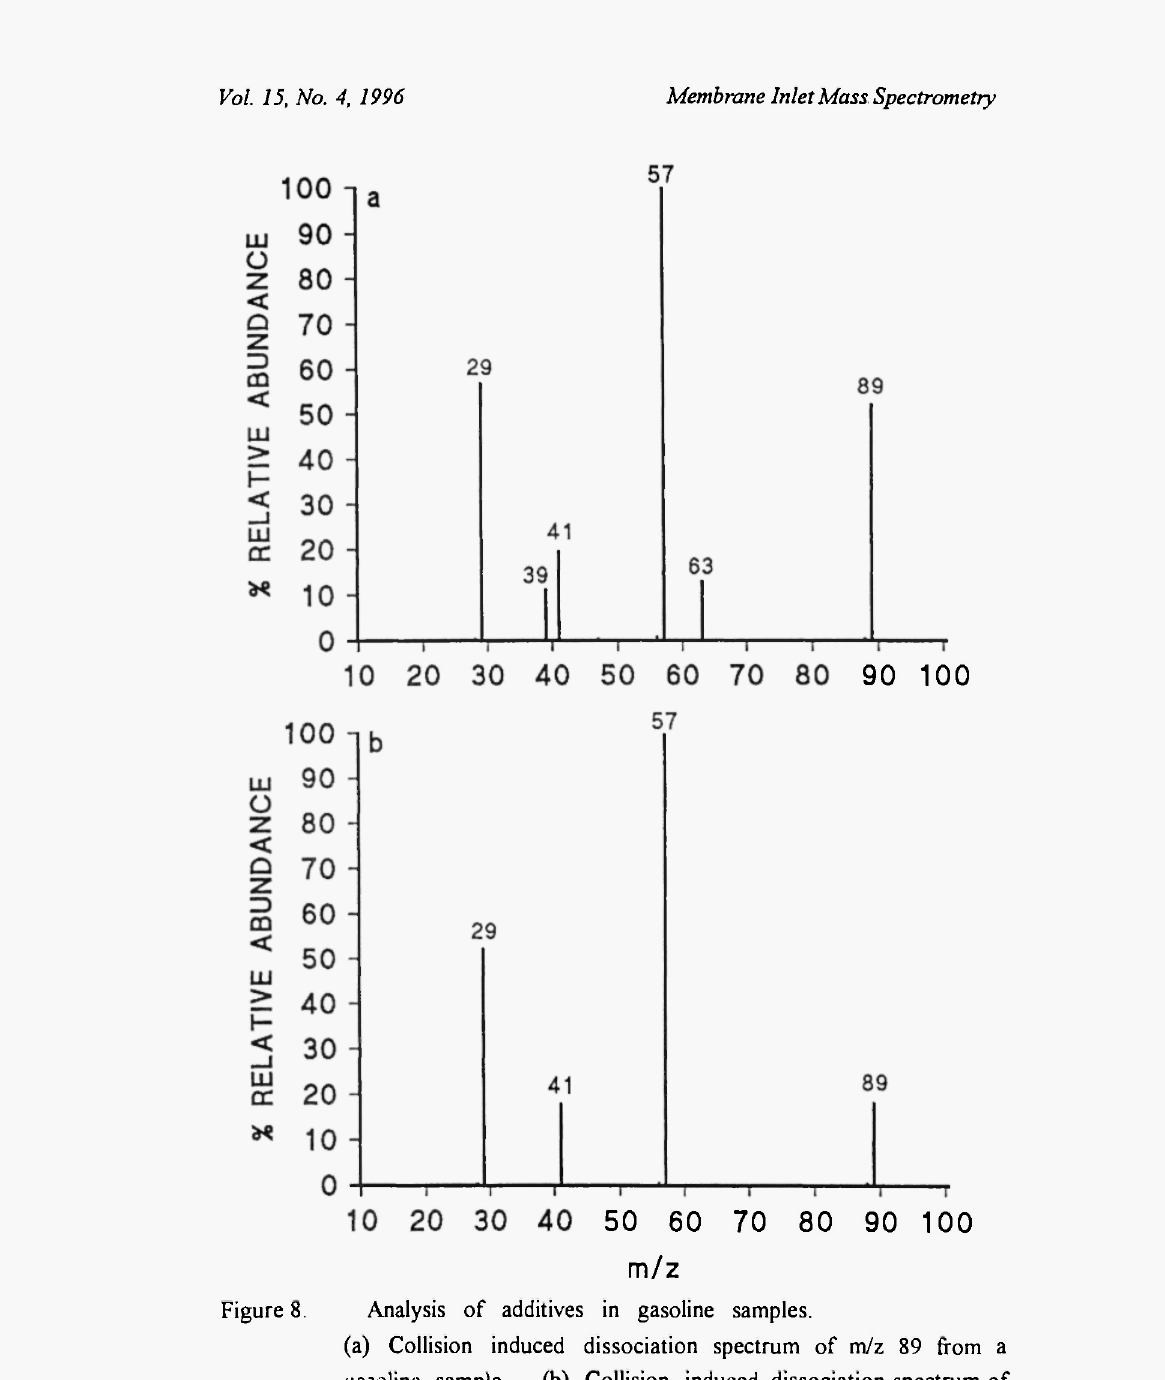
Figure 8. Analysis of additives in gasoline samples. (a) Collision induced dissociation spectrum of m/z 89 from a gasoline sample. (b) Collision induced dissociation spectrum of m/z 89 from a solution of 100 ppm /er/-butyl methyl ether in hexane. Adapted from reference